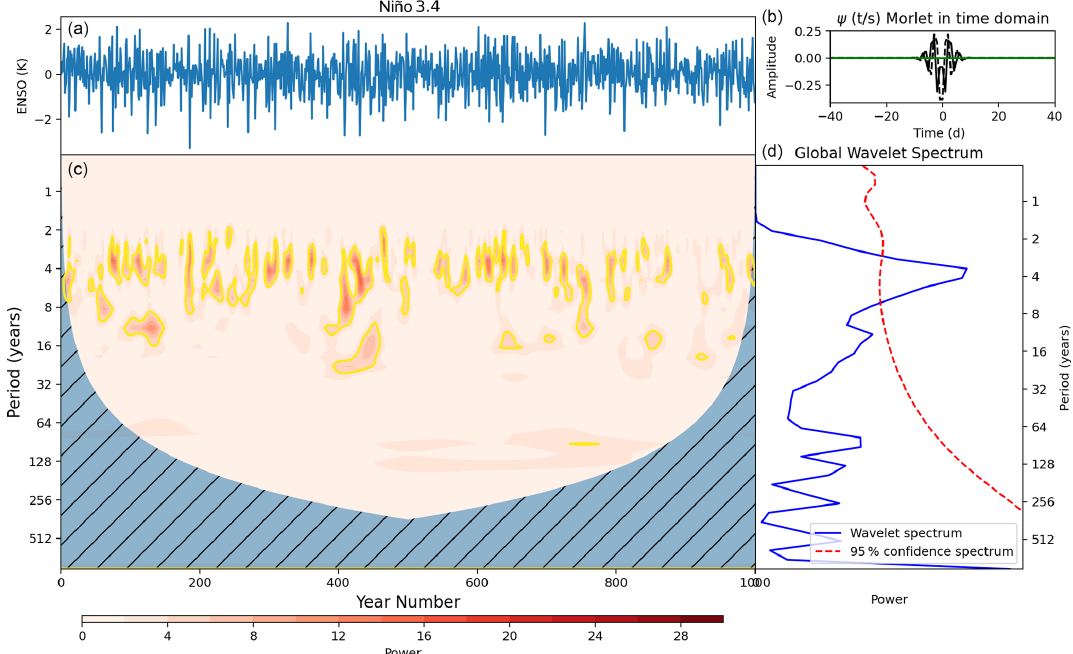
Figure A3. (a) September–November Niño 3.4 index from the UKESM piControl simulation. (c) Wavelet power spectrum of time series in panel (a) . Hatching represents area outside the cone of influence in which edge effects are significant and power should not be considered. Yellow contours represent the 95% confidence level assuming mean background AR1 red noise. (b) Morlet wavelet used for the wavelet transform in the time domain. (d) Global power spectrum, the wavelet power averaged over the whole simulation and global 95% confidence spectrum.